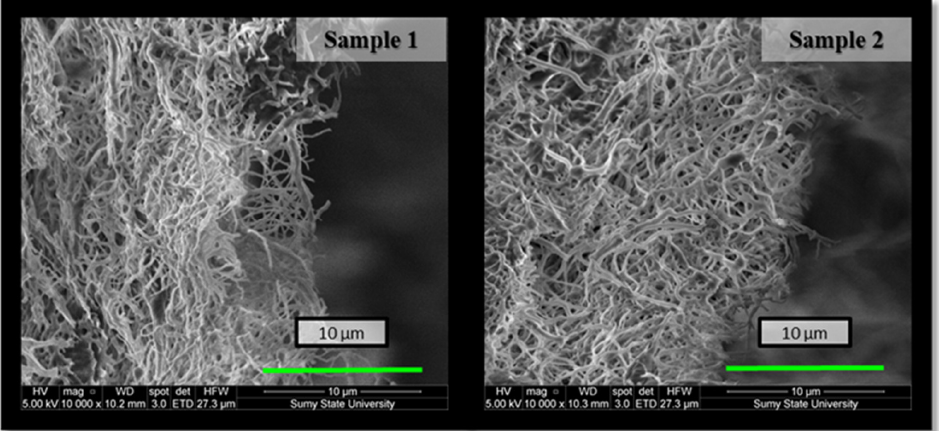
Figure 2. Cross-sectional SEM image of Ch-TFA:DCM 7:3 (sample 1) and Ch-TFA:DCM 9:1 (sample 2) as-spun membranes.